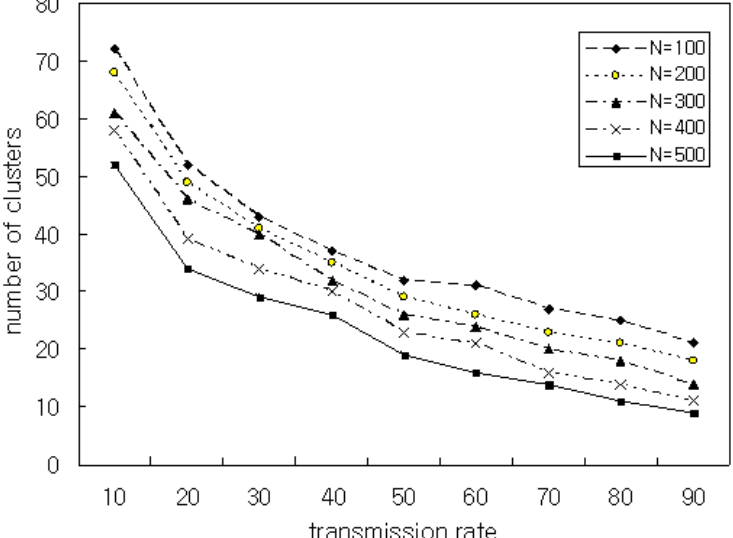
Figure 10. Transmission Rate vs. Number of Clusters with  =